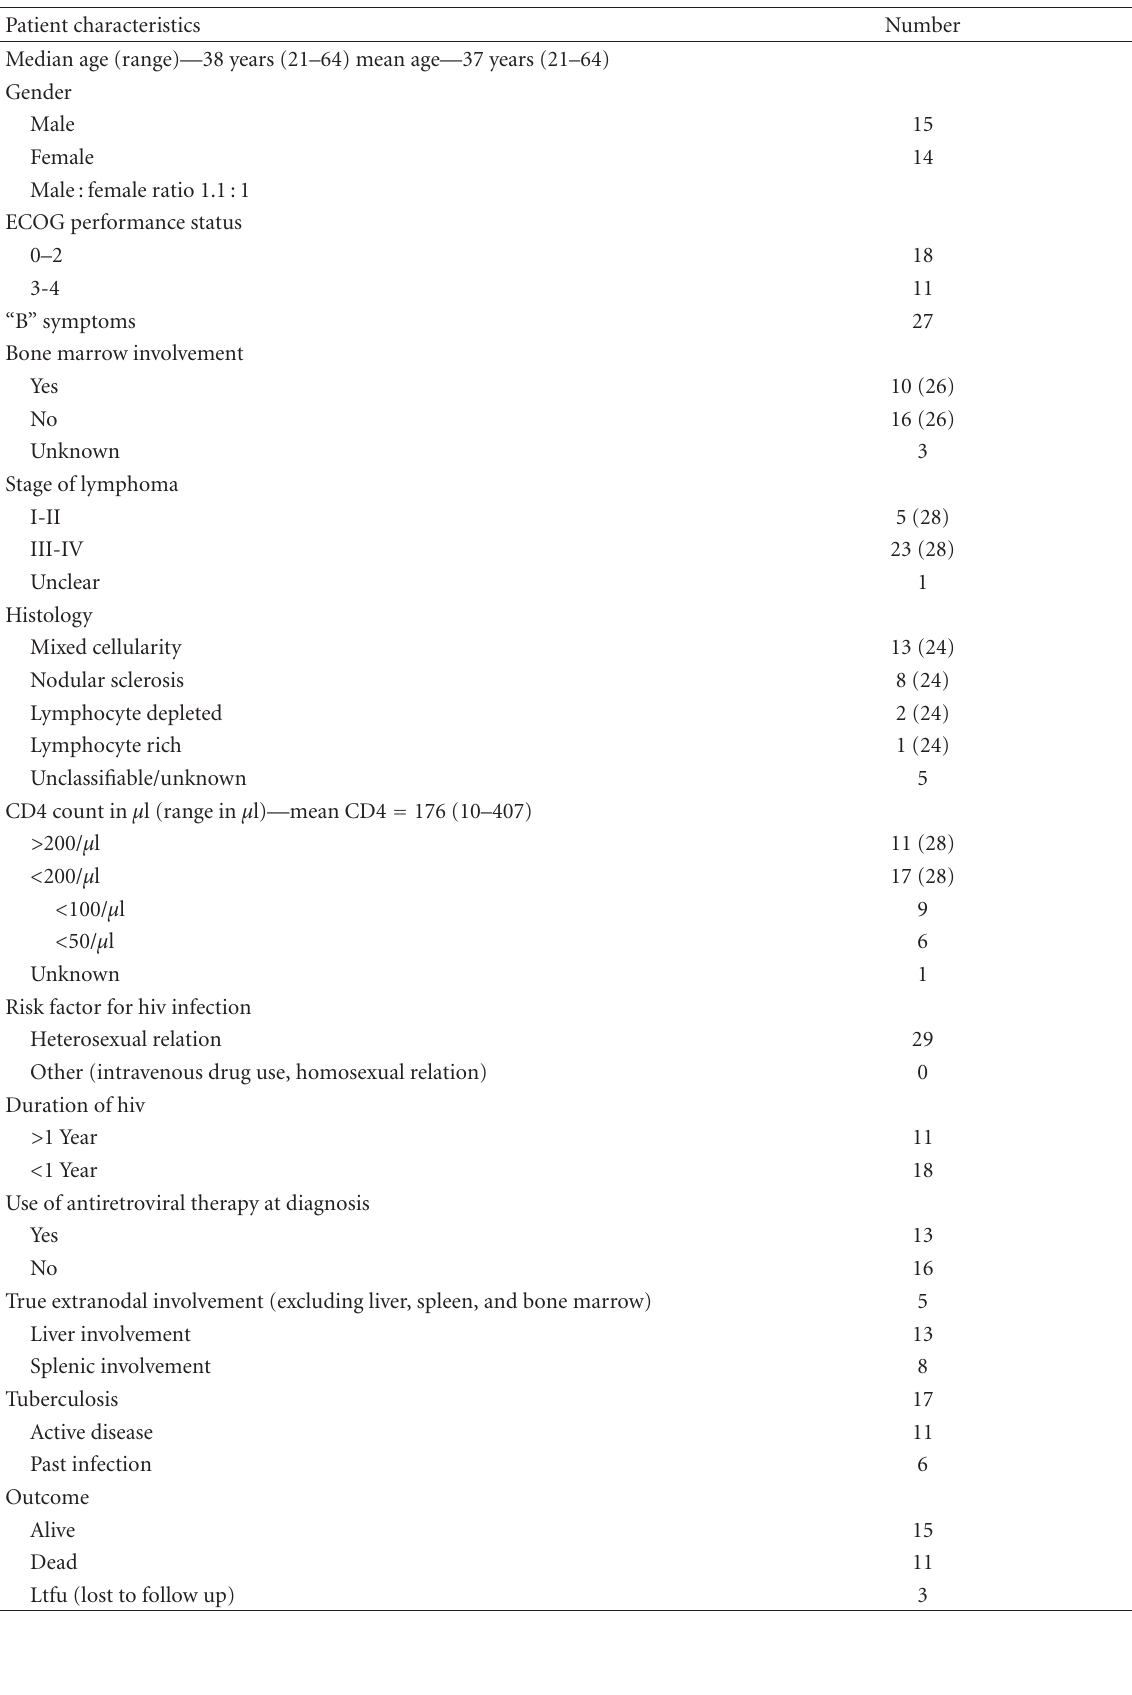
Table 1: Characteristics of patients ( n = 29) with HIV-associated Hodgkin’s lymphoma seen at the Chris Hani Baragwanath Hospital (July 2008 to June